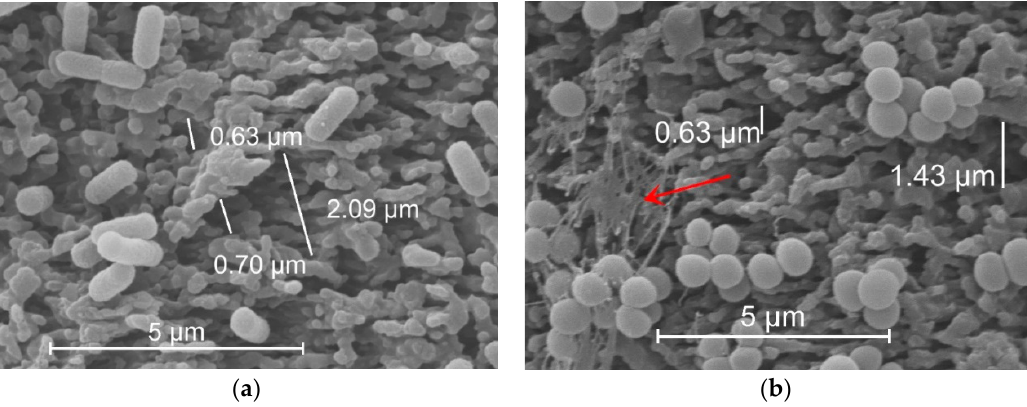
Figure 4. ESEM of E. coli ( a ) and S. aureus ( b ) after 21 h co-cultivation with PE sample on a laser-processed surface area. The arrow in ( b ) indicates EPS matrix. Distance measurements were performed with Nikon Imaging Software NIS-Elements 4.20.